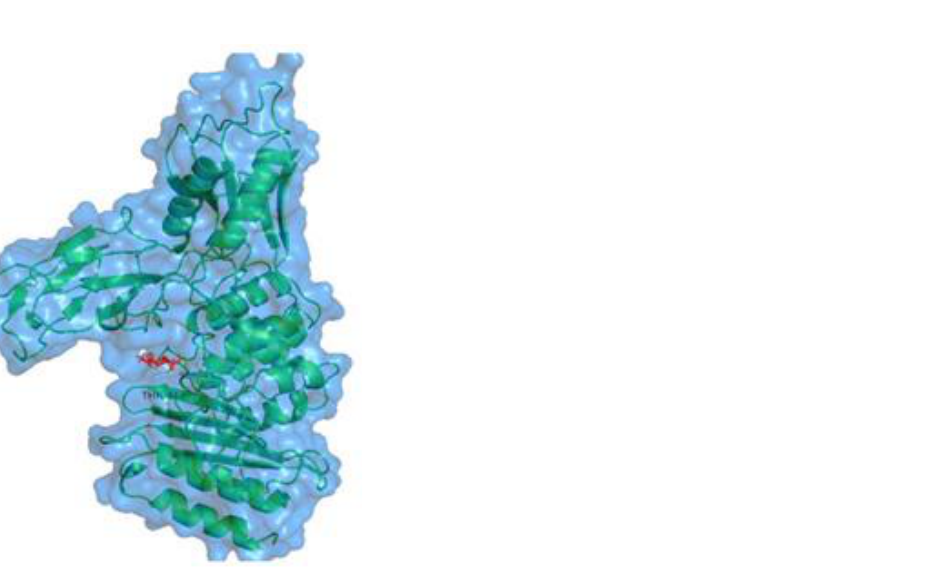
Figure 7. Docking pose of 2-acetamido-2-deoxy-hexopyranose on the binding interaction of PDP. Hydrogen bond interactions indicated by the yellow line.